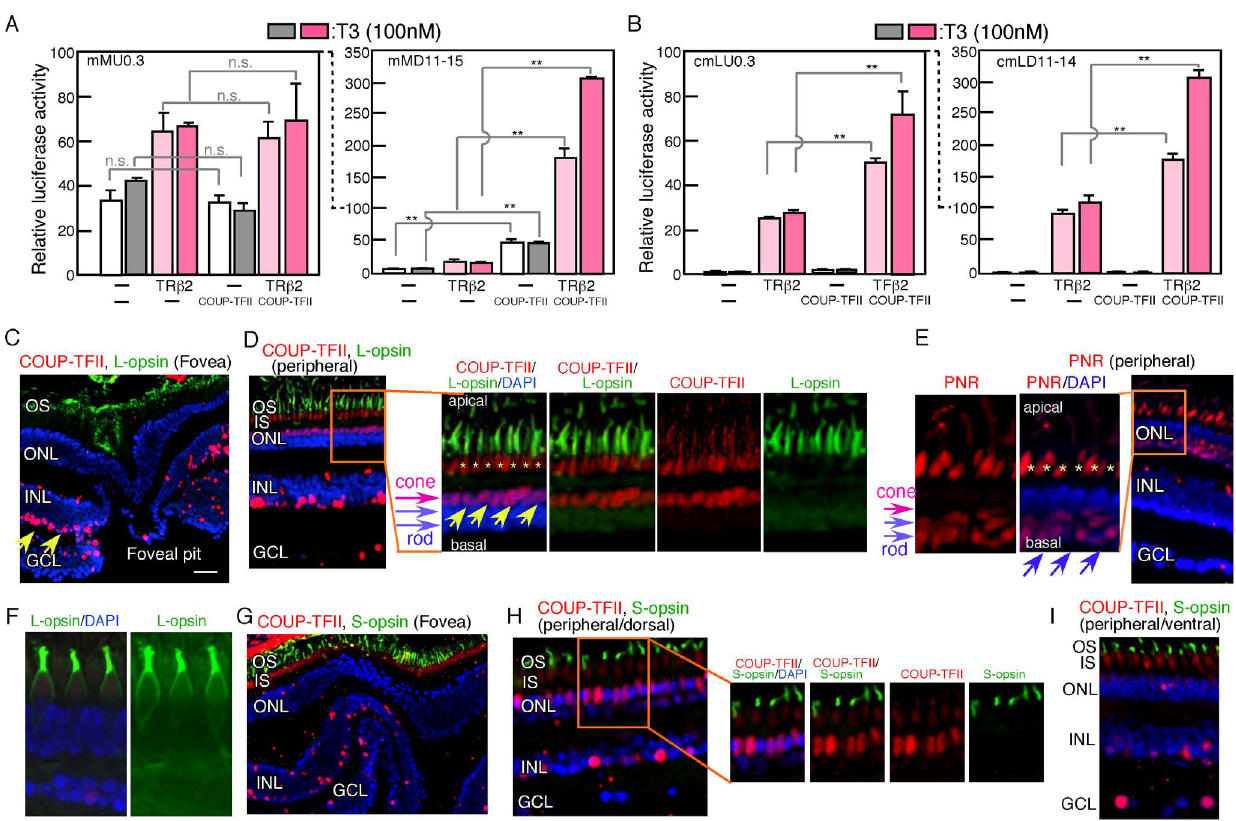
Figure 4. Promoter activities of mouse and common marmoset opsin genes, and expression of COUP-TFs in common marmoset retina. A. Luciferase constructs containing mouse M-opsin promoter (mRU0.3) or M-opsin exon/intron region (mRD11–14) were transfected into HEK293T cells with TRß2 expression plasmid or a control plasmid, and cultured for 12 hours, and T3 (100 nM) was added half of samples and cultured additional 16 hours. Luciferase activities were examined and expressed as relative values. B. Common marmoset long opsin promoter luciferase plasmid (cmLU0.3) or exon/intron construct (cmLD11–14) were transfected into HEK293T cells with TRß 2 expression plasmid and cultured and luciferase activities were analyzed as described for A. p value; ** , 0.01, n.s., (not significant), or actual value was calculated by Student’s t-test. C–F. Expression of COUP-TFII, L (long)-opsin (C, D), and PNR (E) in common marmoset retina. Common marmoset retina was fixed with PFA and frozen sectioned. Immunostaining was done, and photos of foveal pit region (C), peripheral region (D, E) are shown. The right panels in D and left panels in E are enlarged photos of a part indicated by orange squares of left (D) and right (E) photos. Arrows (yellow) in C and D indicate signals of L-opsin, and asterisks in D and E indicate non specific staining. Arrows (blue) in E indicate PNR signals. In outer nuclear layer, nucleus of cone aligned apical one layer (pink arrows), and basal nucleus are rods (blue double arrows) in D, and E. Scale bar in C, 100 m m. F indicates magnified photo of L-opsin immunostaining. G–I. Expression of COU-TFII and S (short)-opsin in common marmoset retina. Photos of foveal pit region (H), peripheral/dorsal (H), and peripheral/ventral (I) regions are shown. The right panels in H are enlarged photos of the part indicated by a yellow square in H. OS, outer segment; ONL, outer nuclear layer; INL, inner nuclear layer; GCL, ganglion cell layer; IS, inner segment. to be present at high density in the foveal region, whereas the expression of COUP-TFII was not clear in this region (Fig. 4C). In the peripheral region, COUP-TFII was expressed in the cone cells, in which L-opsin was also expressed (Fig. 4D, arrows in enlarged panel). Rod cells, labeled with PNR (photoreceptor-specific nuclear receptor protein, NR2E3) [26], did not show expression of COUP-TFII (Fig. 4E). The signals indicated by asterisks in the right panels of Figure 4D and E are non-specific signals. Enlarged photo of L-opsin staining (Fig. 4F) indicates L-opsin only in outer segments. Therefore, signals for L-opsin and COUP-TFII were not merged, but we conclude that they are expressed in the same cells, since COUP-TFII expressed in all cones in this region. S- opsin and COUP-TFII immunostainings are shown in Fig. 4G, 4H and 4I, and both COUP-TFII and S-opsin were expressed in cone cells in the peripheral region (Fig. 4H, I).